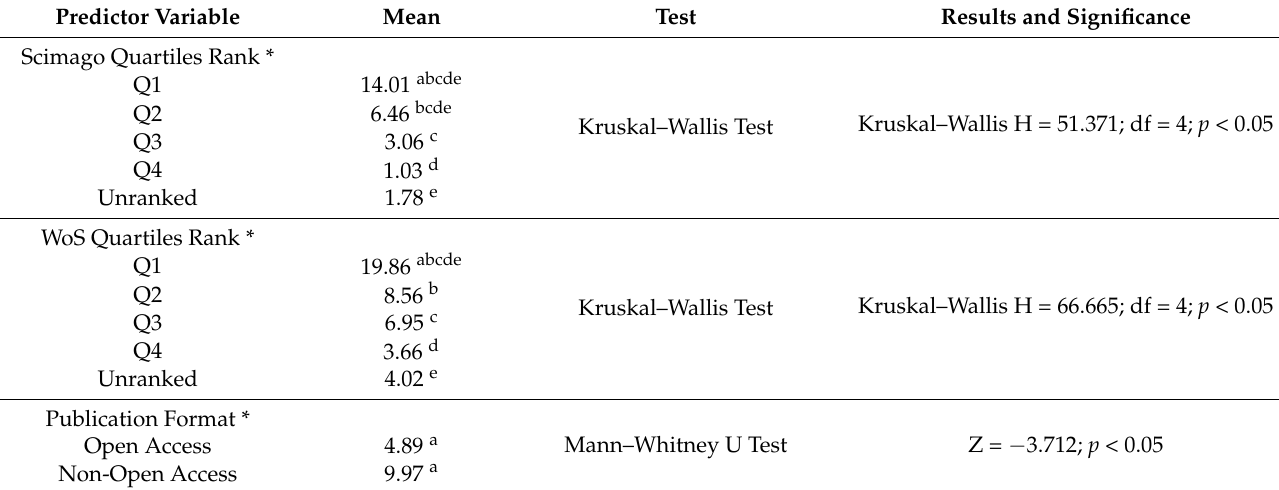
Table 2. Results of association tests between journal-related variables and number of citations.